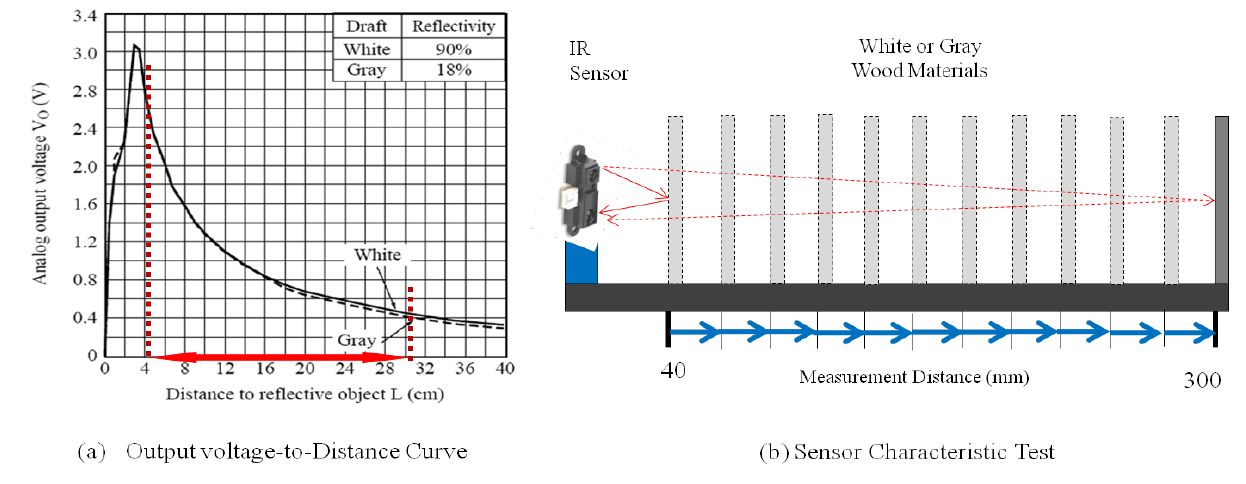
Figure 6. Output voltage-to-distance curve and sensor characteristic